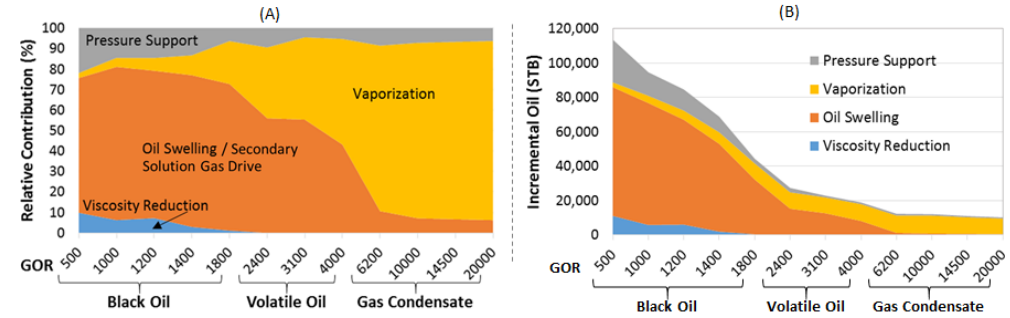
Figure 15. Contribution of four different recovery mechanisms for gas injection in unconventional reservoirs: ( A ) relative percentage and ( B ) fraction of the incremental oil production.